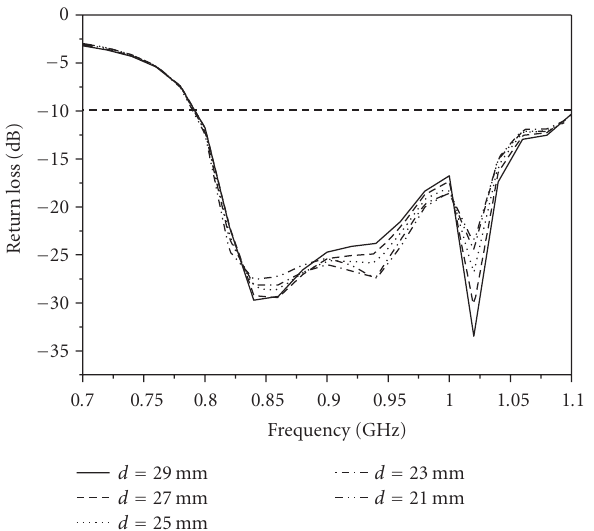
Figure 8: E ff ects of varying diameters of the feeding probes on impedance